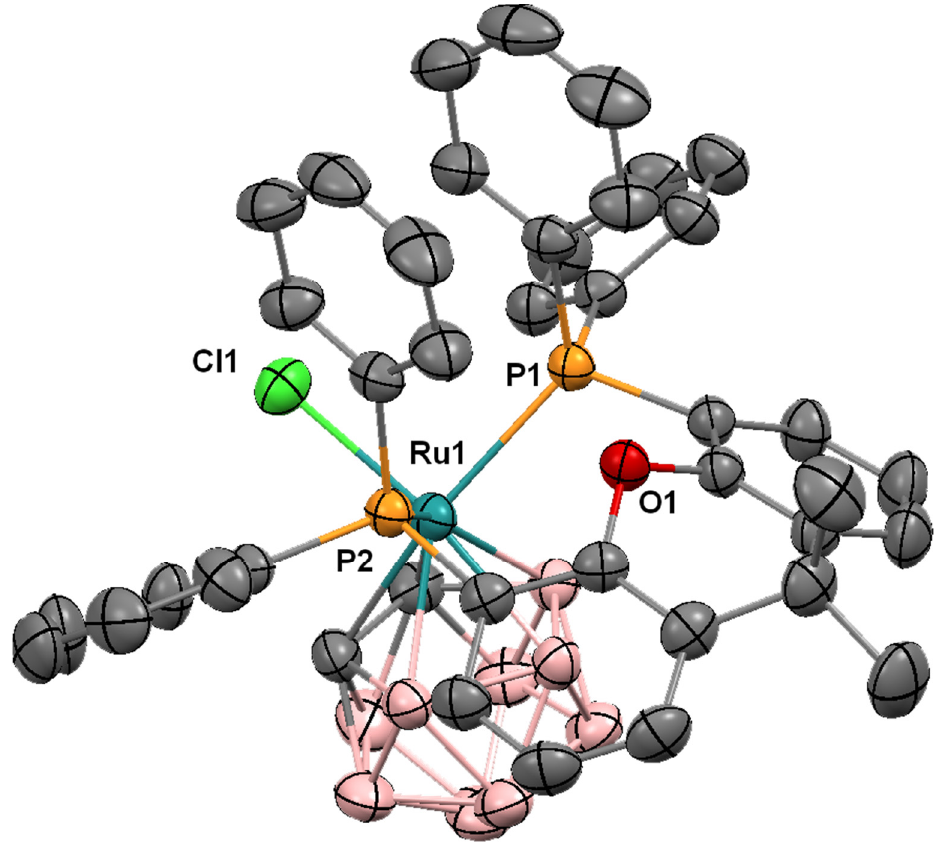
Figure 1. Molecular structure of ruthenacarborane 2 (thermal ellipsoids drawn at the 50% probability level). Hydrogen atoms have been omitted for clarity.